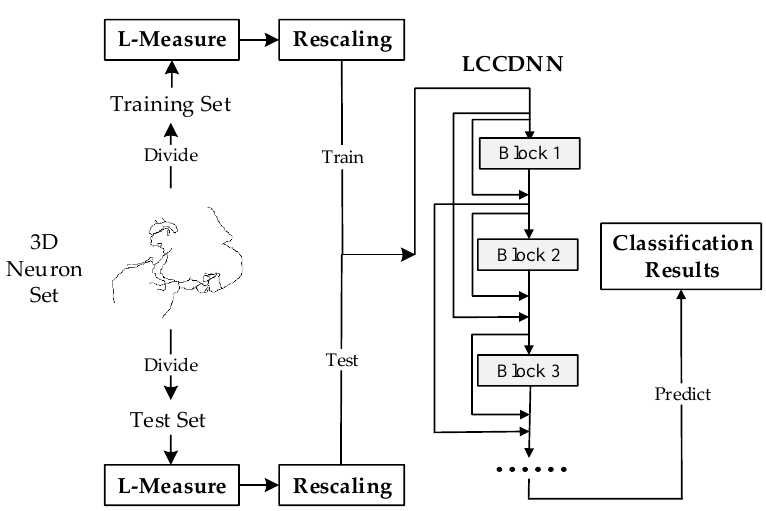
Figure 8. The neuronal morphology classification process based on the LCCDNNs.